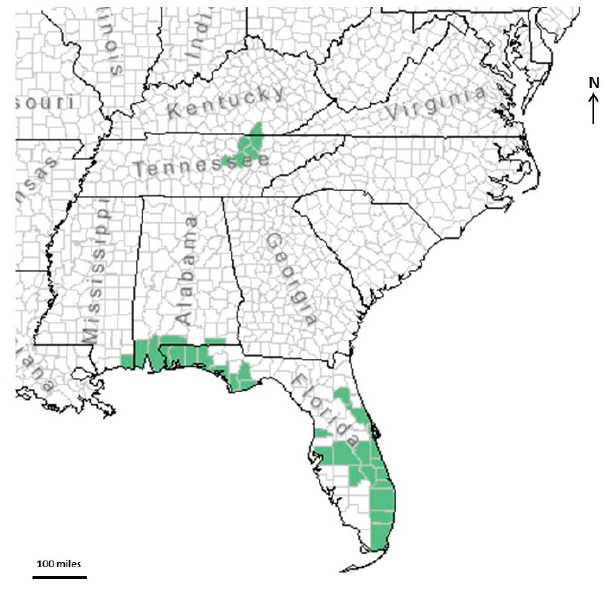
Figure 1. Locations of known populations of Conradina species.